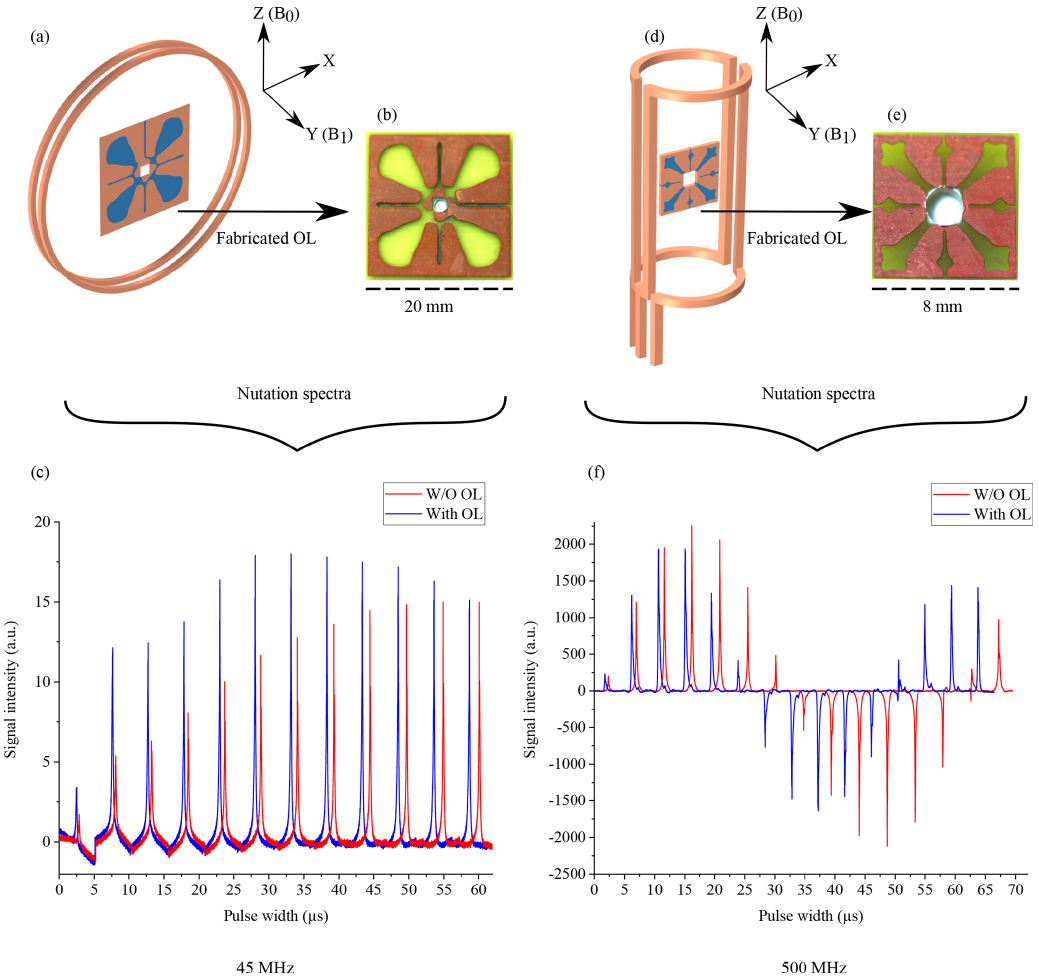
Figure 6. (a, d) The coil type and OL arrangement used for the NMR measurement at 45MHz. The axis represents the orientation of the device in the NMR measurement apparatus. (b, e) Fabricated OLs on the PCBs. (c, d) Fourier transformation of the measured nutation spectra with and without the OLs.